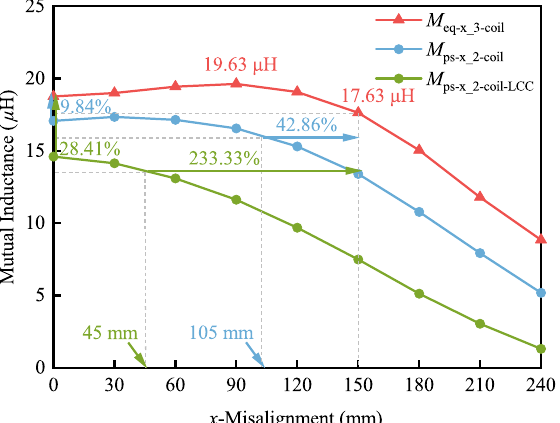
Figure 8. Variations of M eq − 3 − coil , M ps − 2 − coil , and M ps − 2 − coil − LCC versus x -misalignment from 0 to 240